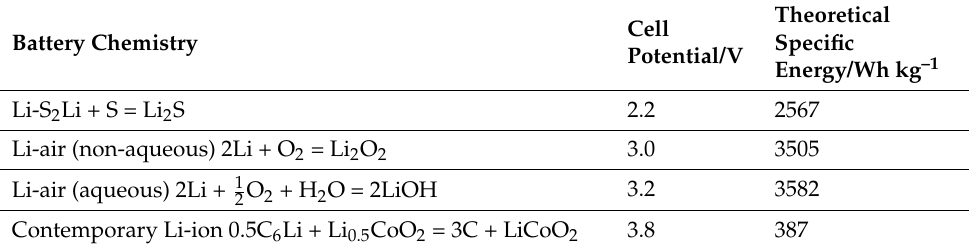
Table 1. Theoretical energy storage for LIBs. Battery Chemistry